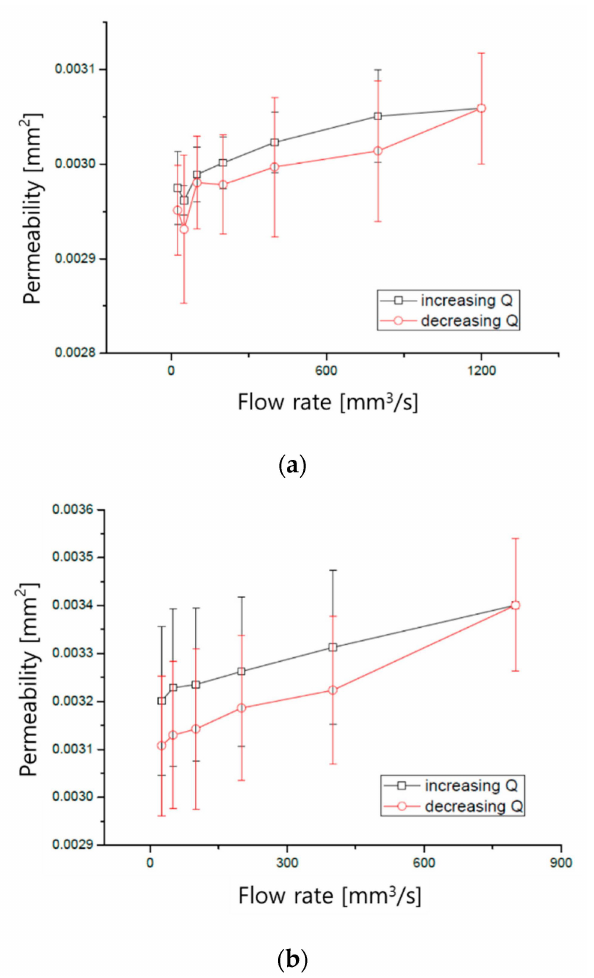
Figure 3. Permeability behavior with different flow rate under different viscosities: ( a ) 97 cP, ( b ) 340